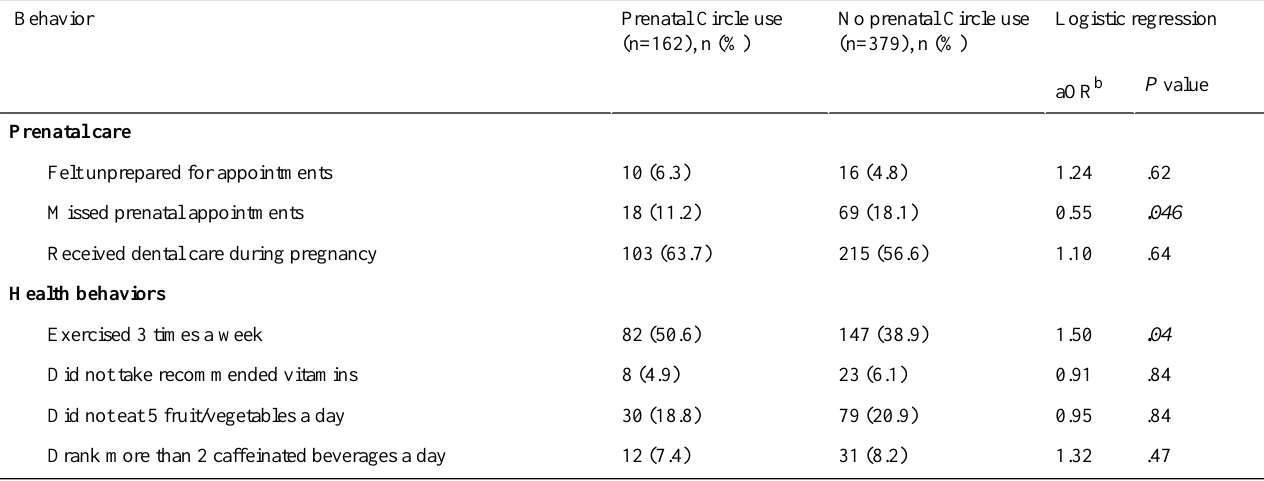
(%)Prenatal Circle use (n=162), n (%)